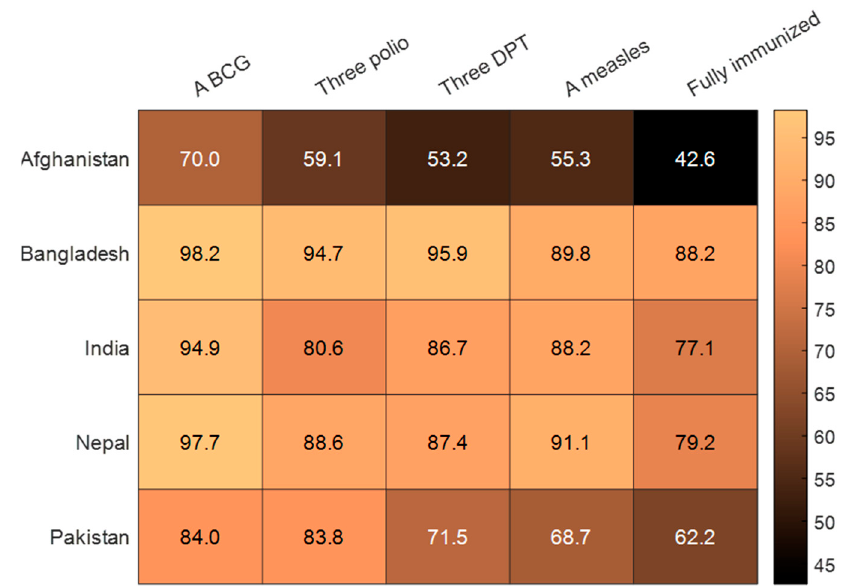
Figure 1. Childhood immunisation by vaccine type in South Asia.